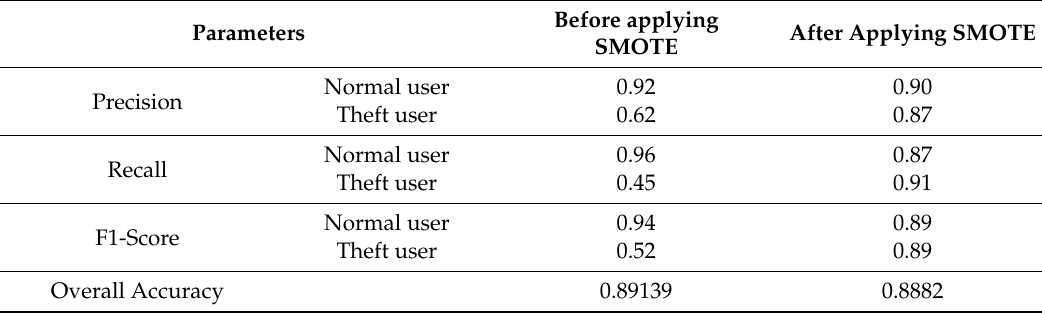
Table 2. Model performance on the class-imbalanced and balanced datasets.